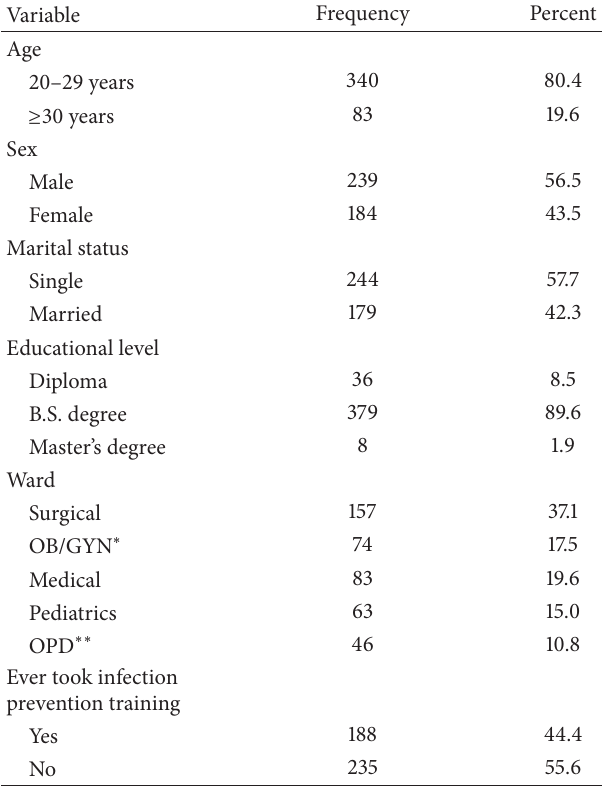
Table 1: Sociodemographic characteristics of the study participants, Gondar and Debre Markos Referral Hospitals, Northwest Ethiopia, 2015 ( 𝑛 = 423